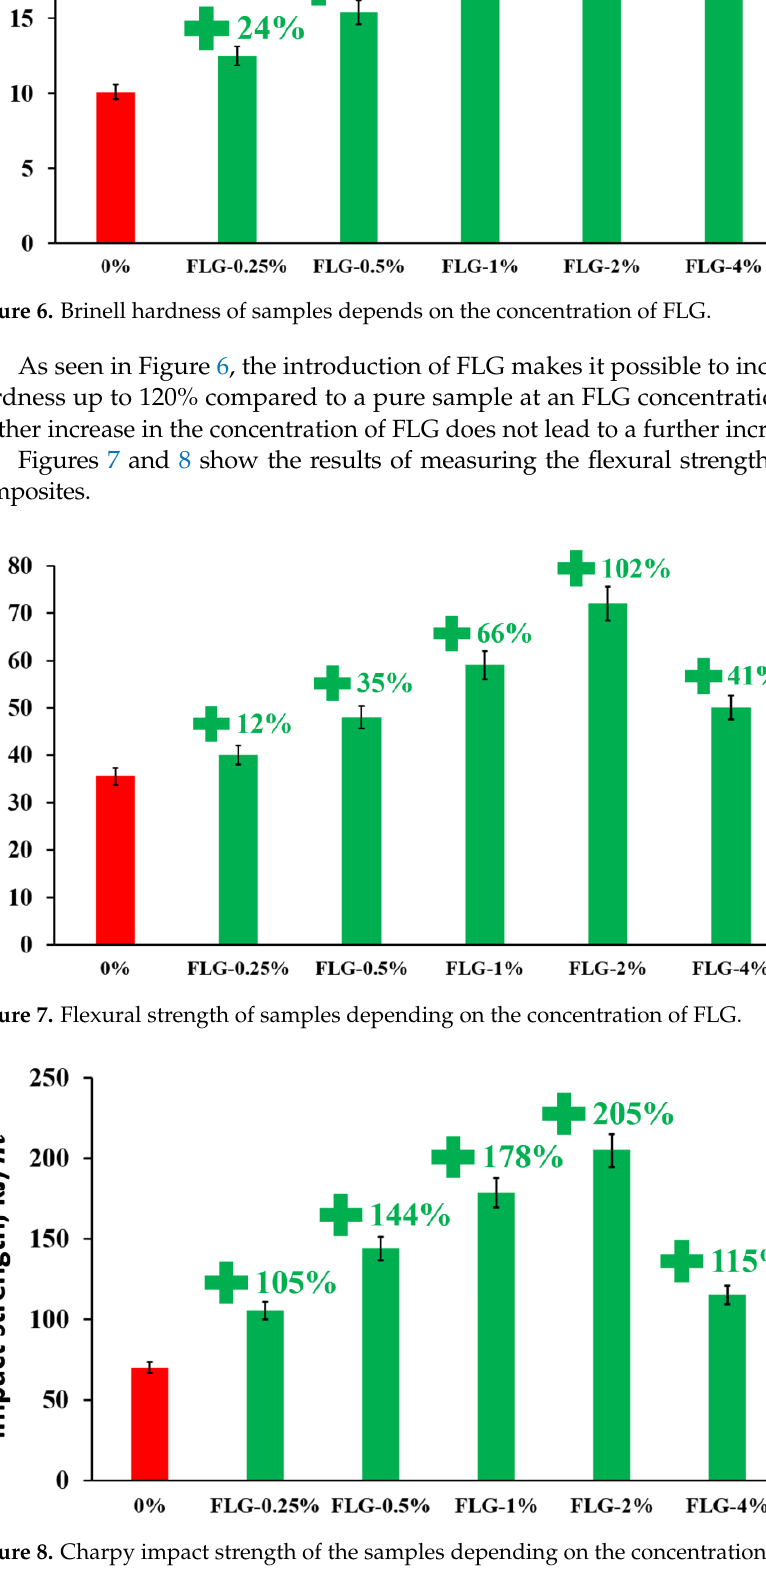
( d ) Figure 5. SEM images of ( a ) cleavage sample (fractured surfaces) from the original resin (linear scale 100 µm); ( b ) modified 1 wt. % FLG (linear scale 100 µm); ( c ) modified 1 wt. % FLG (linear scale 20 µm); and ( d ) modified 1 wt. % FLG (linear scale 2 µm).